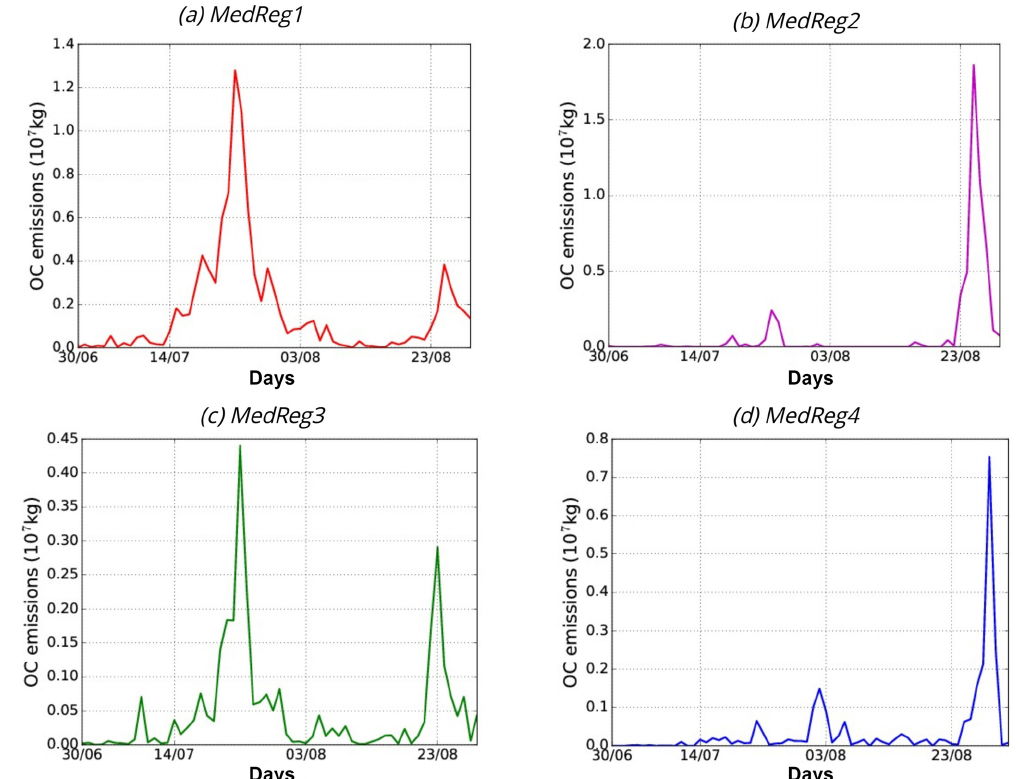
Figure 2. Daily total OC emissions calculated by APIFLAME during the summer of 2007 in the four sub-regions of Fig. 1.